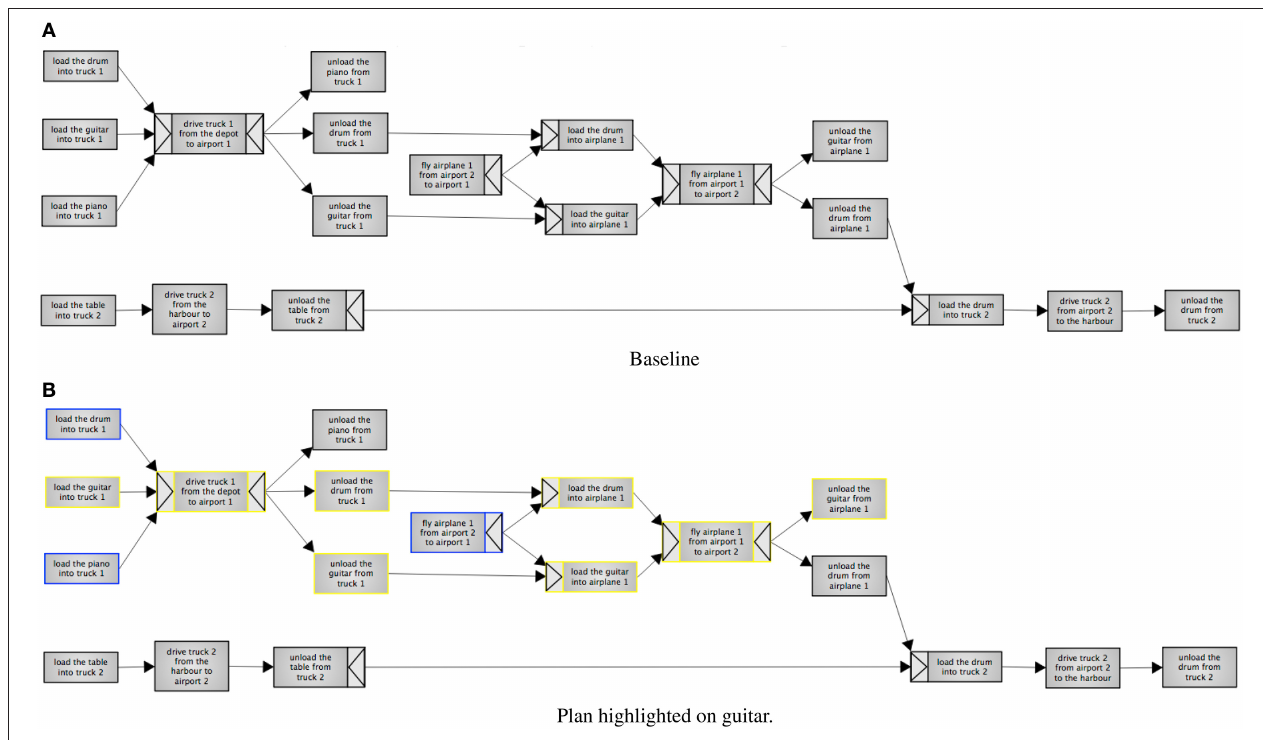
FIGURE 4 | Experiment 2, the baseline condition. The baseline contains the full plan without any emphasis. Highlighting is on “guitar.” Steps with a blue border involve the guitar directly, whereas steps with yellow borders are dependencies. (A) Baseline. (B) Plan highlighted on guitar.